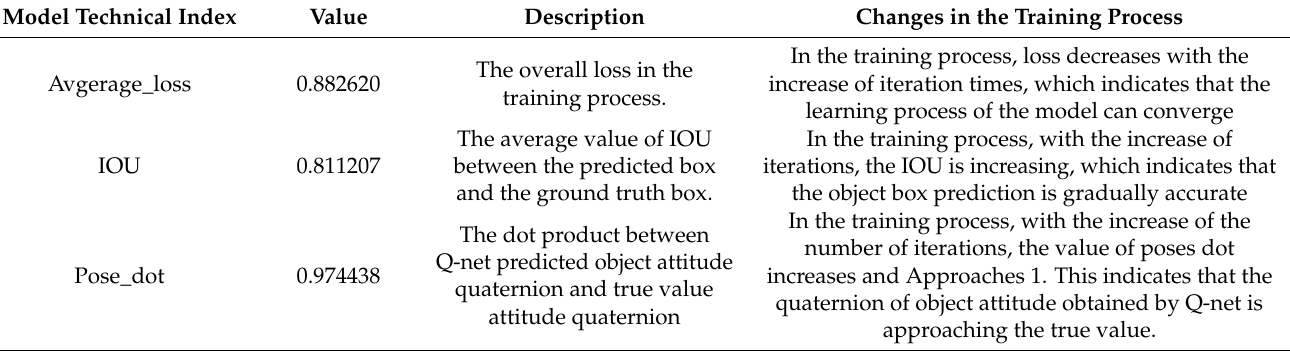
Table 6. The technical index of the pose in model